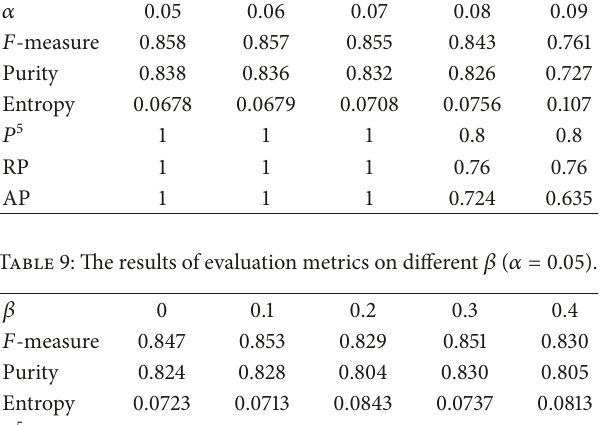
Table 10: The results of evaluation metrics under different semantic conditions.